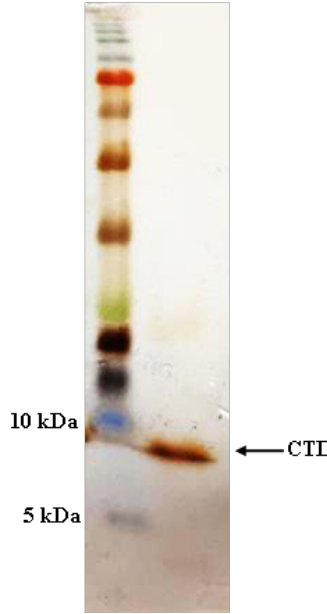
Figure 1. SDS-PAGE analysis of expressed and purified recombinant cytotoxin II.